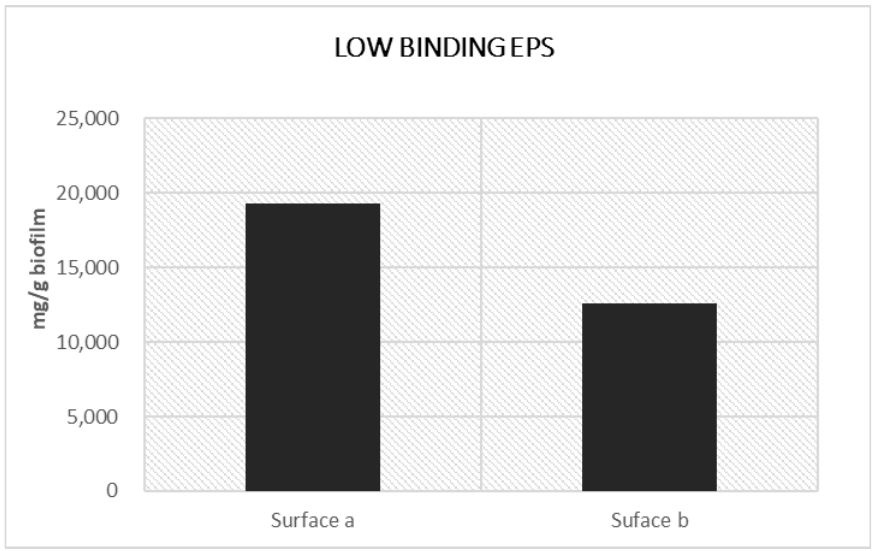
Figure 5. LB-carbohydrates present in biofilm patinas from Surface a and Surface b. Colorimetric analyses also establish differences in the distribution in the a*b* chart (Figure 7a,b, see Section 3.3) of color points from biocolonized (t 0 ) Surface a and Surface